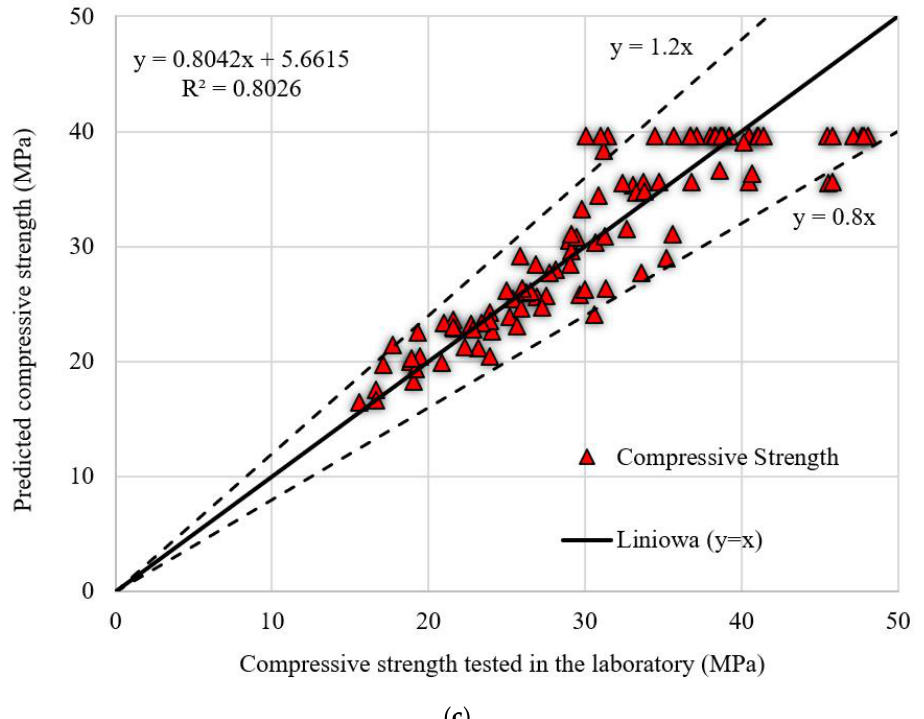
Figure 8. Comparison between the experimental and informational models for the compressive strength of eggshell powder modified concrete ( a ) SFLA-ANN, ( b ) MLR, and ( c ) GA-ANN.